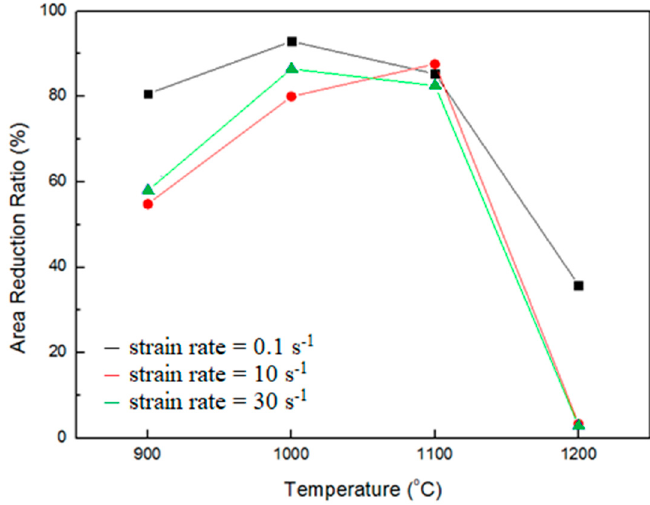
Figure 7. Reduction in the area of the tensile test specimen at different temperatures and strain rates.